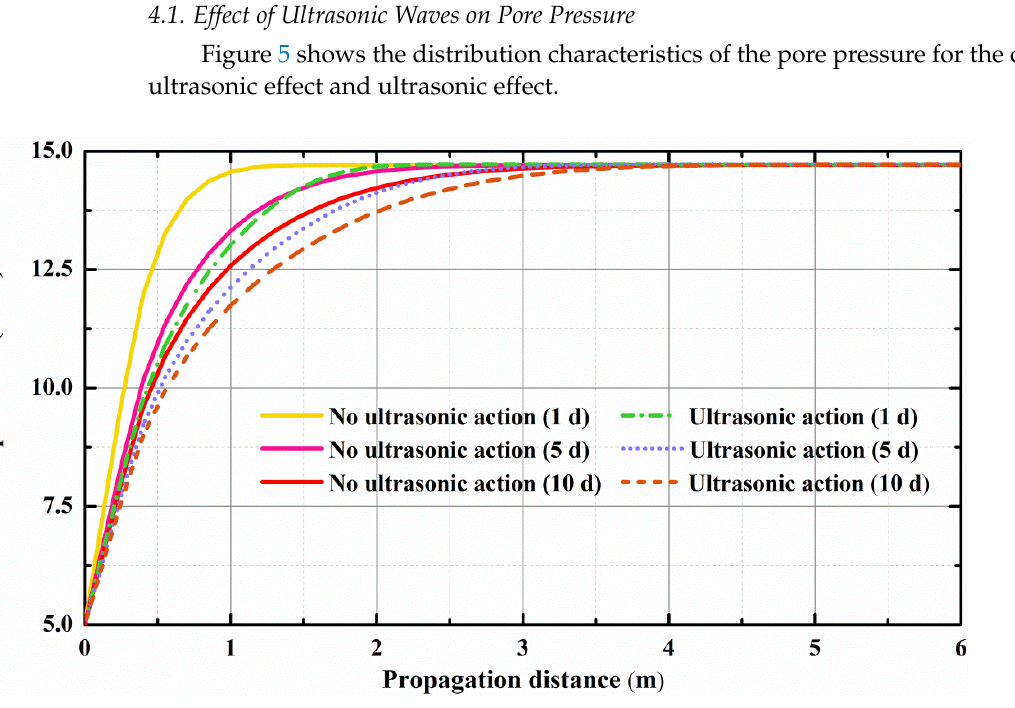
Table 1. Relevant parameters used during mathematical modeling.